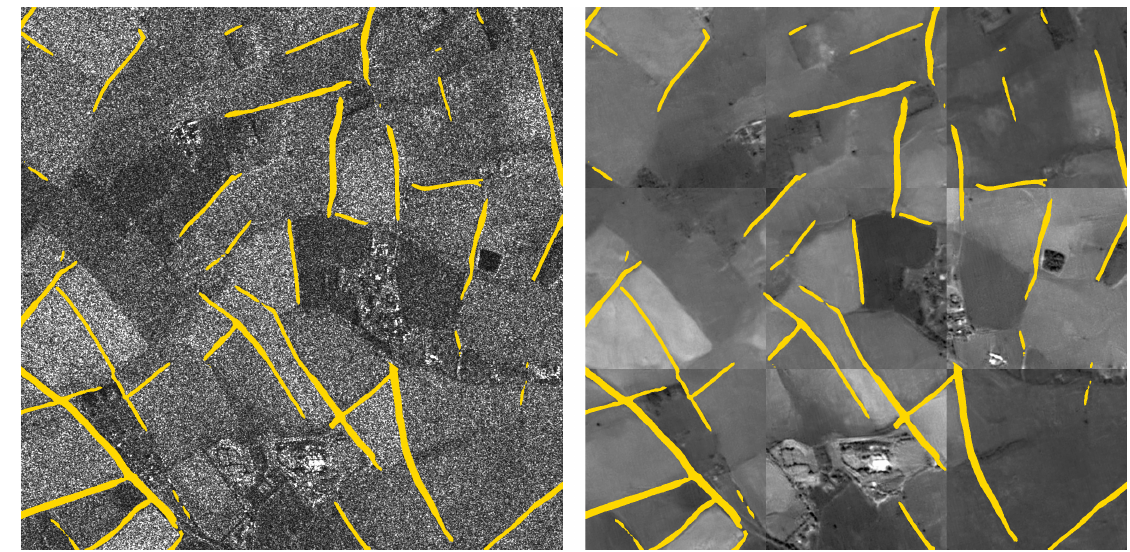
Figure 7. Overlay of the road candidates detected on SAR (marked yellow) over the SAR image ( left ) and CycleGAN image ( right